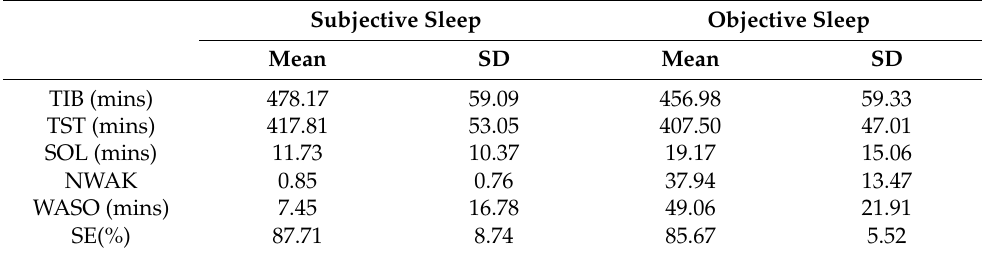
Table 2. Summary of subjective and objective sleep from observational study phase (n = 16).